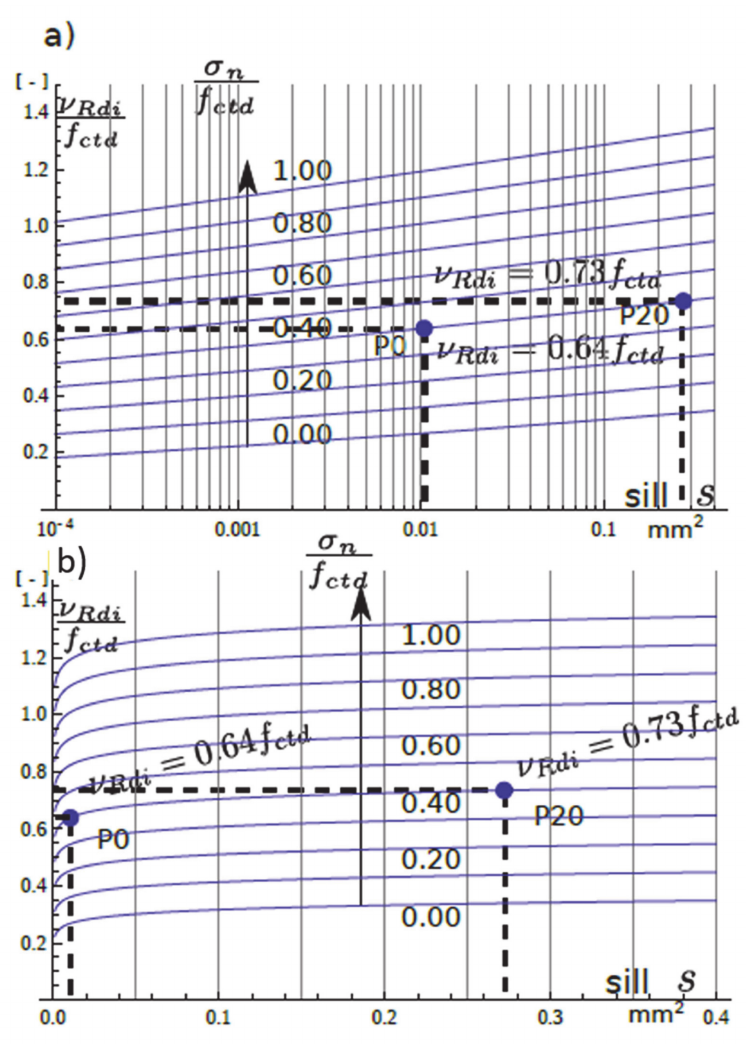
Figure 19. Plots of the relative interface shear strength as a function of the geostatistical sill—s parameter. ( a ) half-logaritmic scale of sill— s ; ( b ) linear scale of sill— s